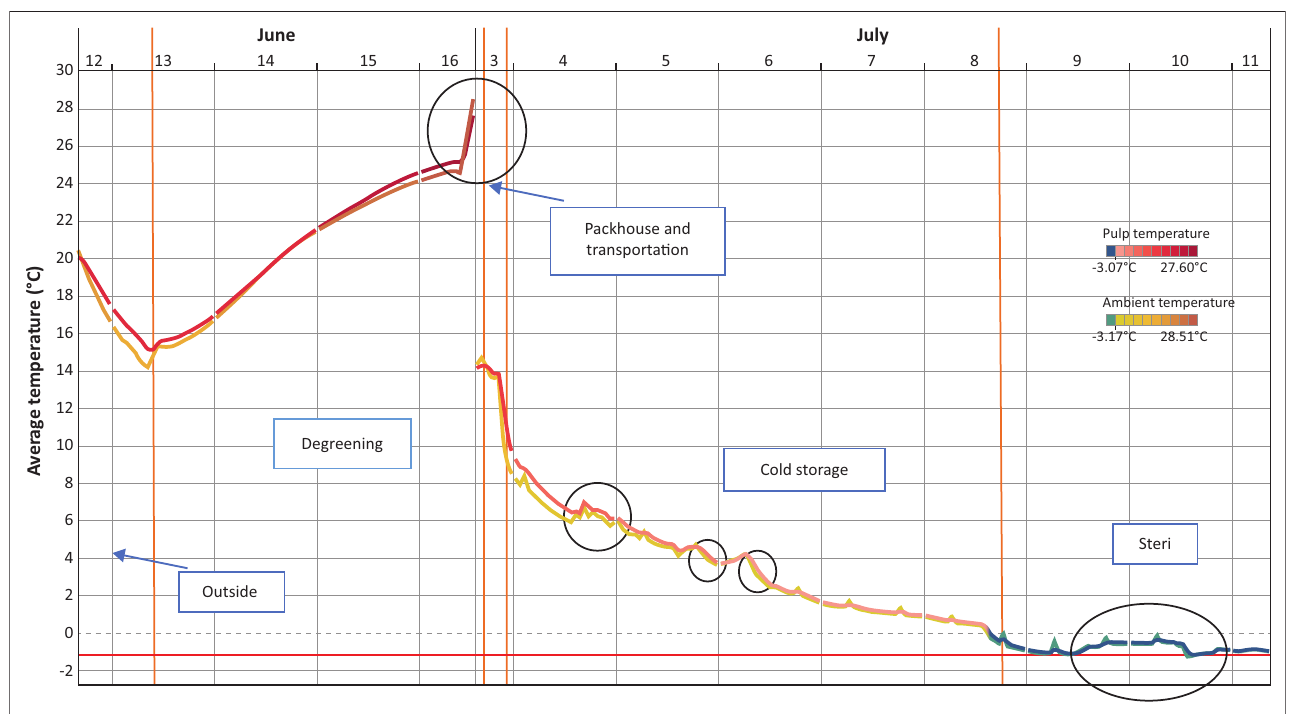
FIGURE 7: Time-series line graph of navels load one: Pulp and ambient temperature.